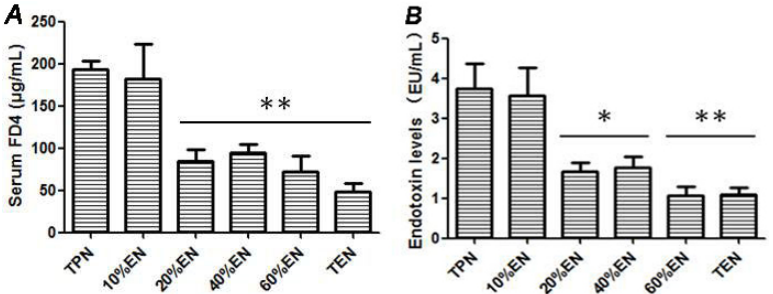
Figure 6. The analysis of intestinal barrier permeability. ( A ) Serum FD ‐ 4 level assay of in vivo test of epithelium permeability of rats. TPN and 10%EN groups had increased serum FD ‐ 4 concentrations.